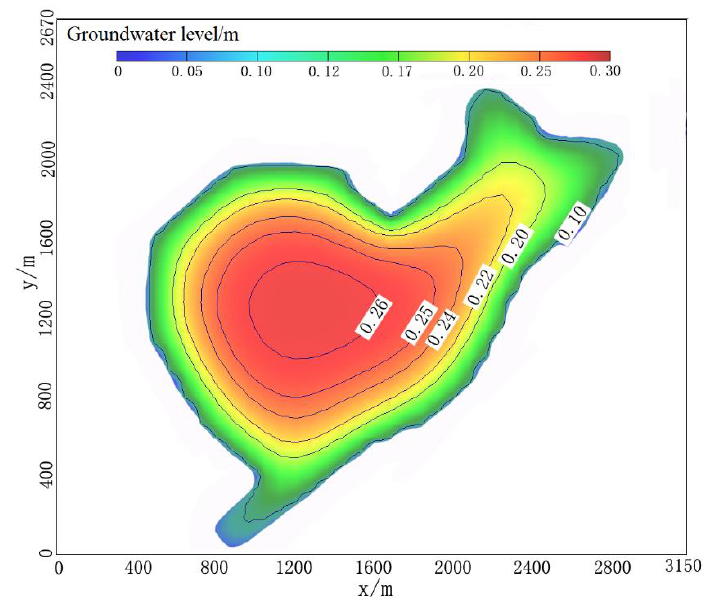
Figure 7. Head distribution above sea level on reclaimed islands.